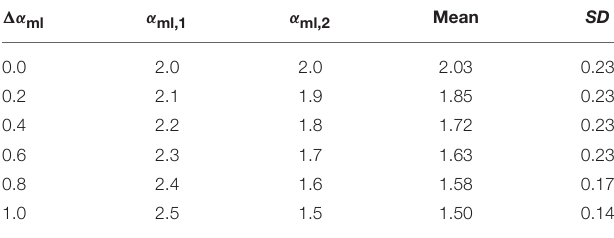
TABLE 5 | Means and standard deviations of the recovered mixing-length values in the full coupled scenario, depending on the 1α ml adopted in the generation. 1α